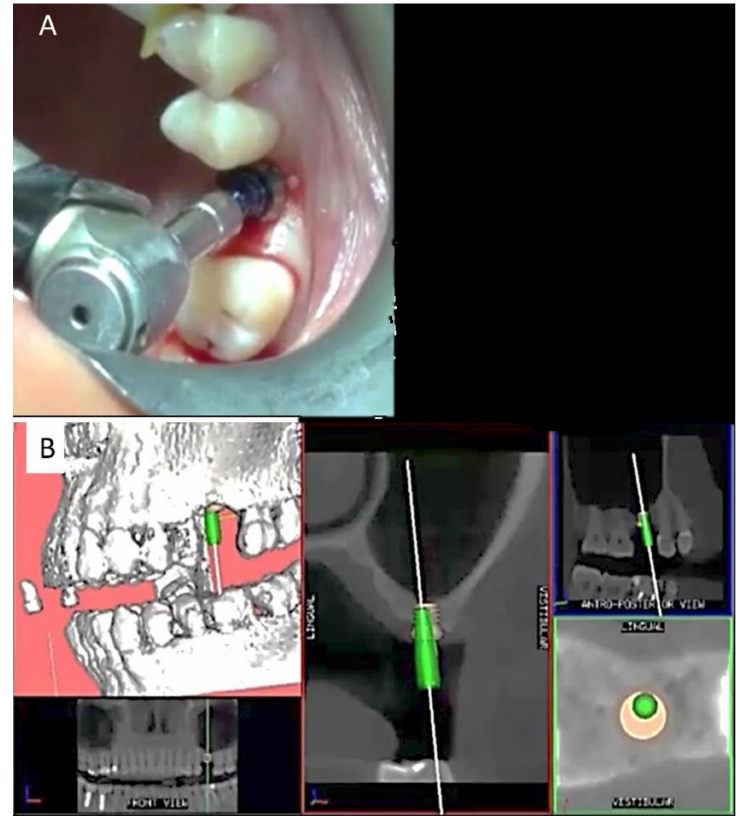
Figure 4. Clinical view of the implant screw sitting ( A ) and the screen view showing the final implant digital position, and the green pin representing the fixture superimposed on the 3D radiologic anatomy ( B ).